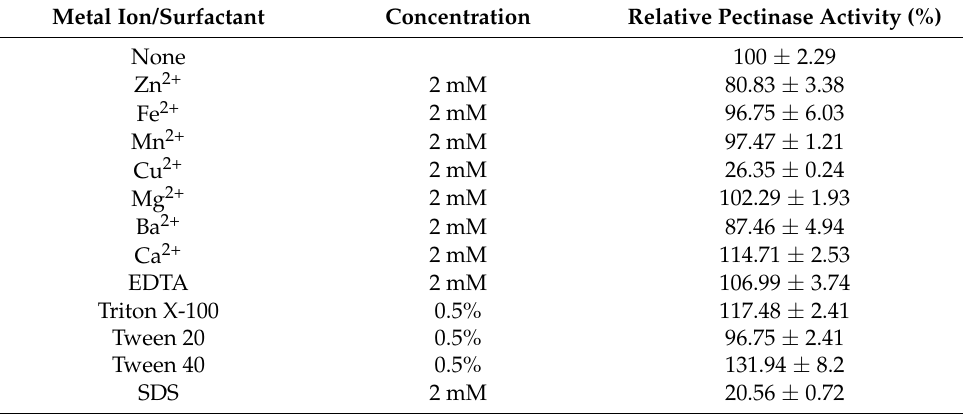
Table 4. Effects of various chemicals on the activity of B. amyloliquefaciens TKU050 pectinase. All error bars are the ± SD (standard deviation) of three different